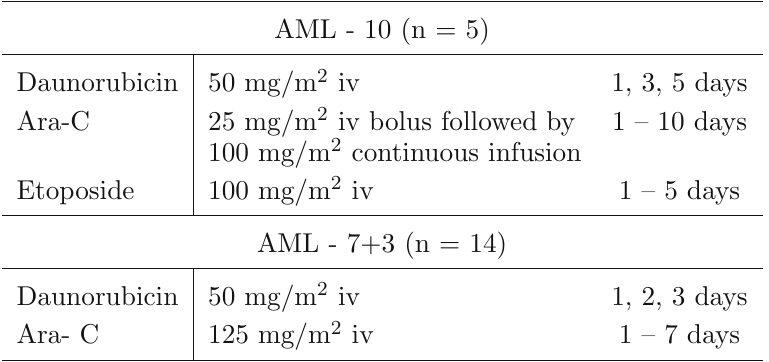
Table 2 Cytostatic protocols for treatment of AML